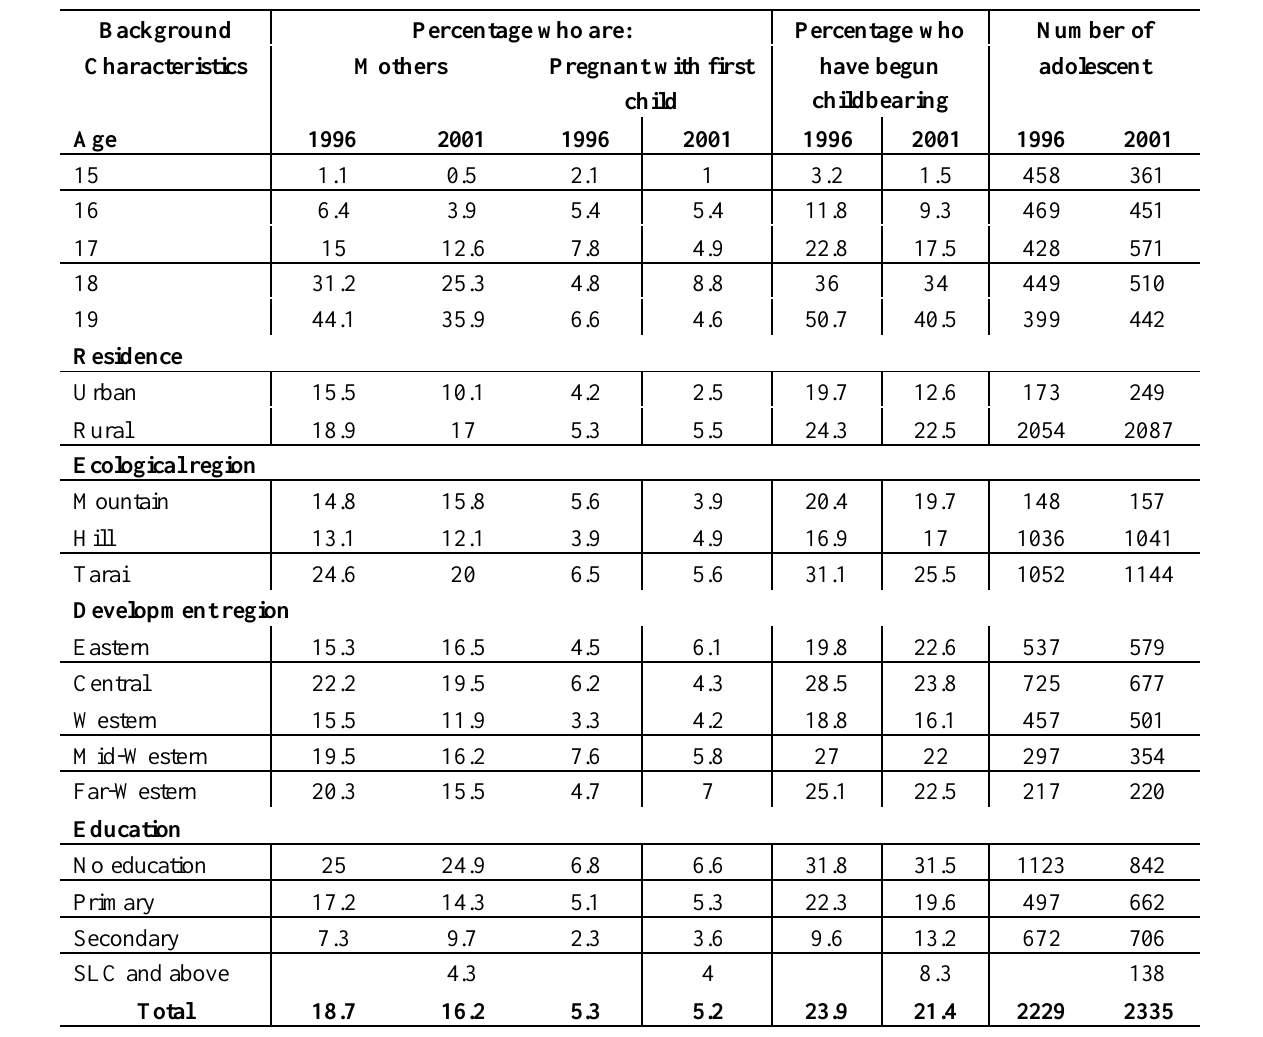
Table I : Percentage of all females (ever-married never-married) aged 15-19 years who are mothers or pregnant with their first child with selected